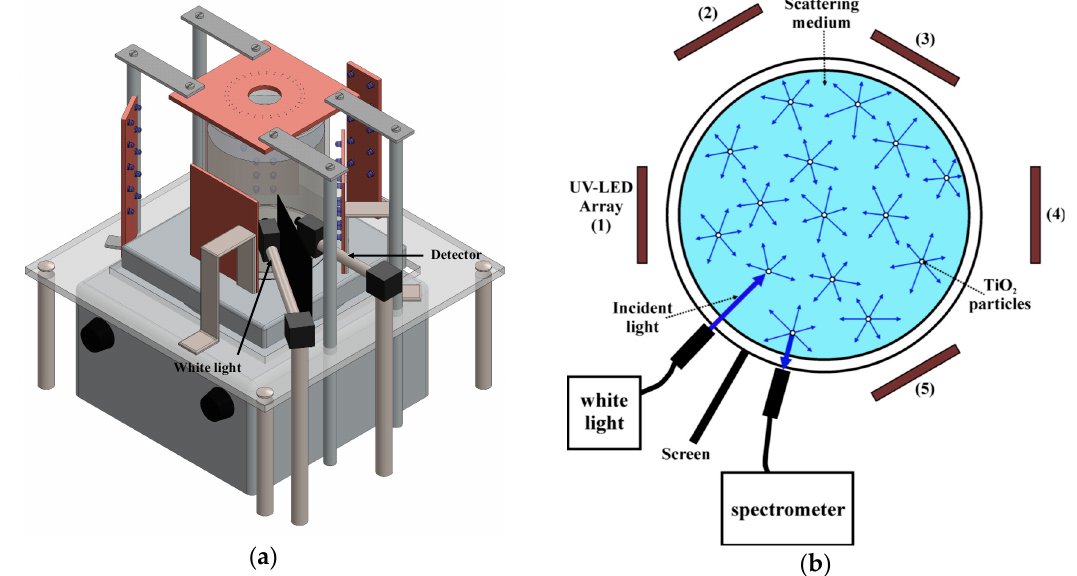
Figure 15. Schematic diagrams. ( a ) Reactor with decolorization monitoring configuration. ( b ) Sample scattering and monitoring system (top view).